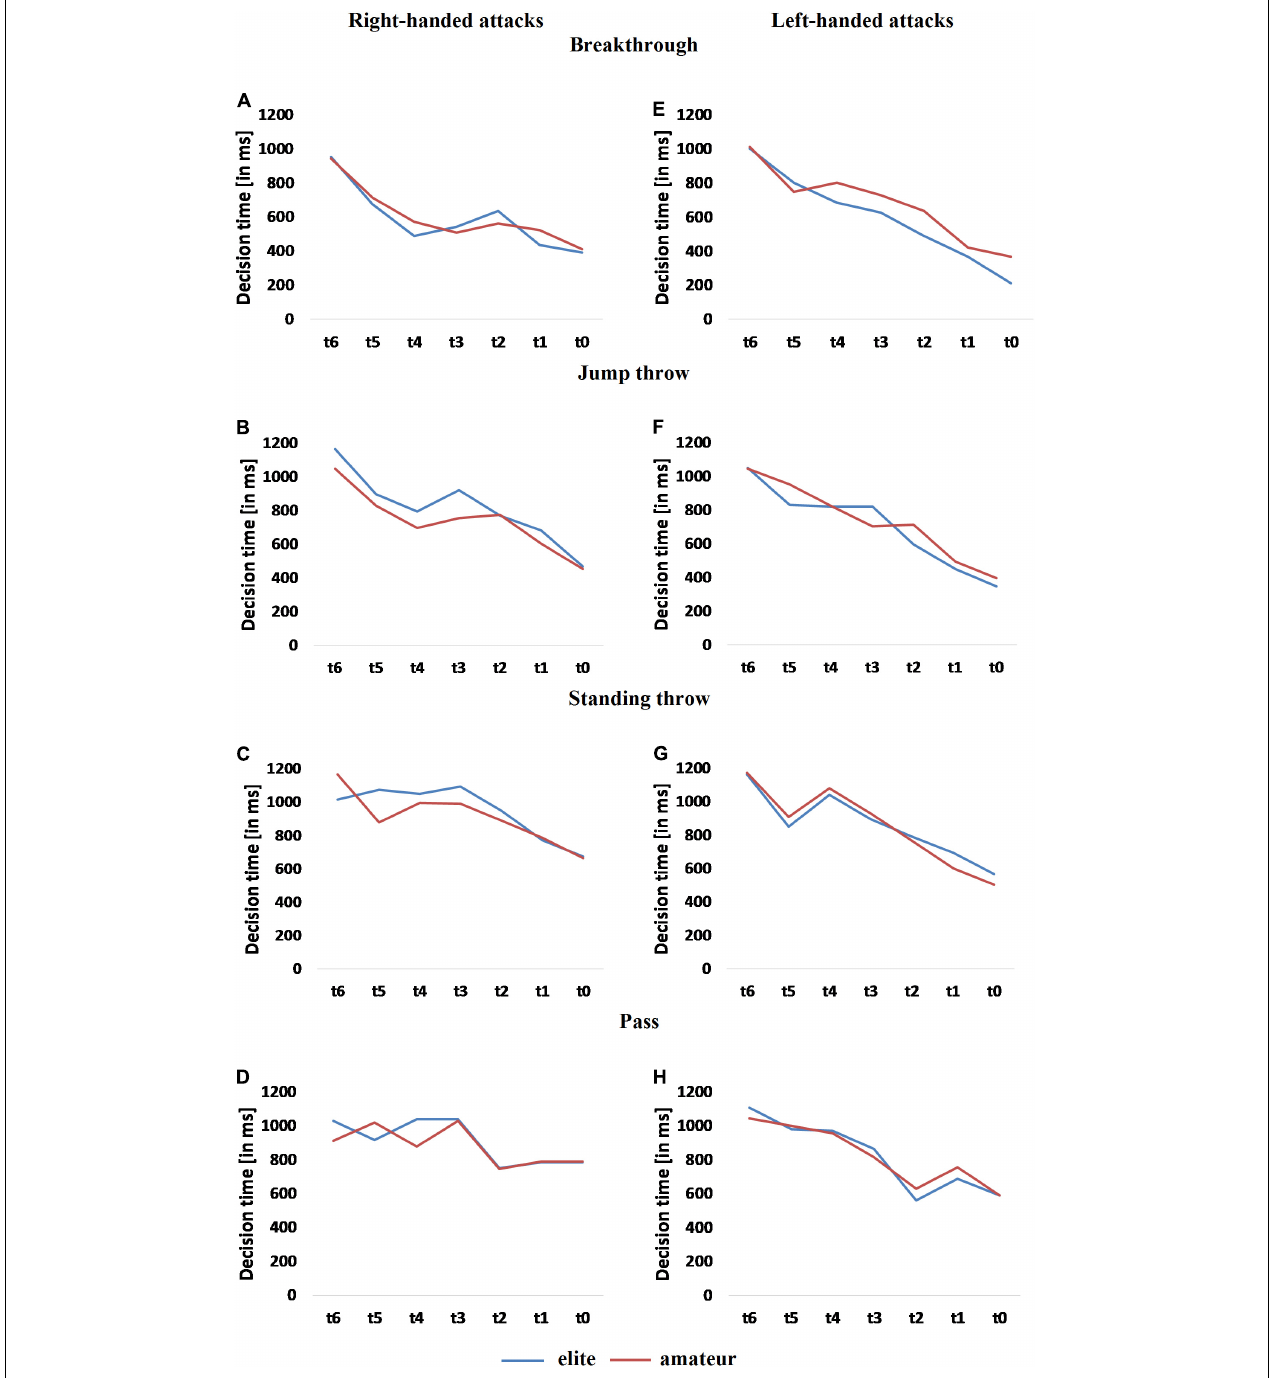
FIGURE 2 | Comparisons of aggregated decision times for all responses between elite and amateur players in right- (A–D) and left-handed (E–H)